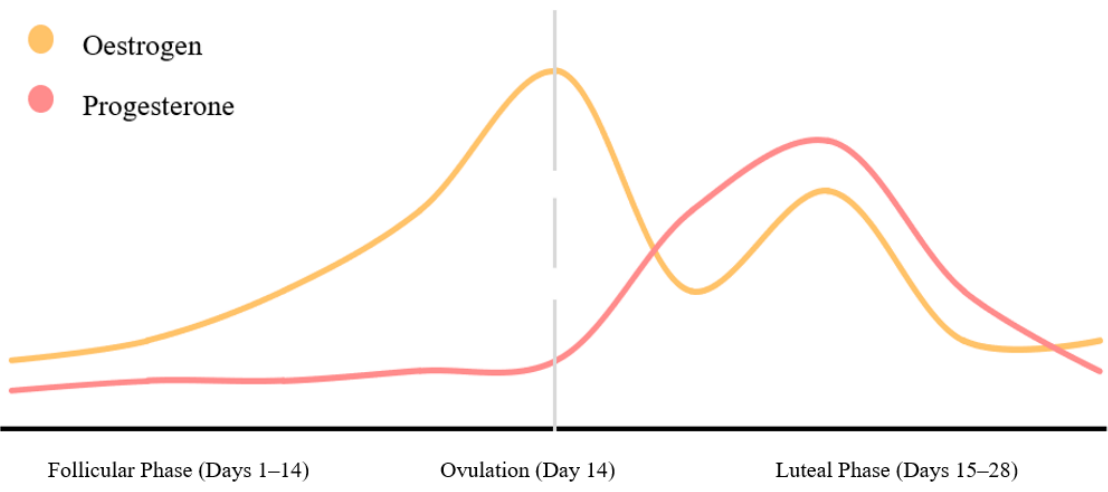
Figure 1. Stages of the menstrual cycle and associated hormonal fluctuations. Note : Grey line highlights the halfway point of a standard 28-day cycle. It is at this point that Oestogren is at its peak. The primary hormones involved in the menstrual cycle have been shown to impact